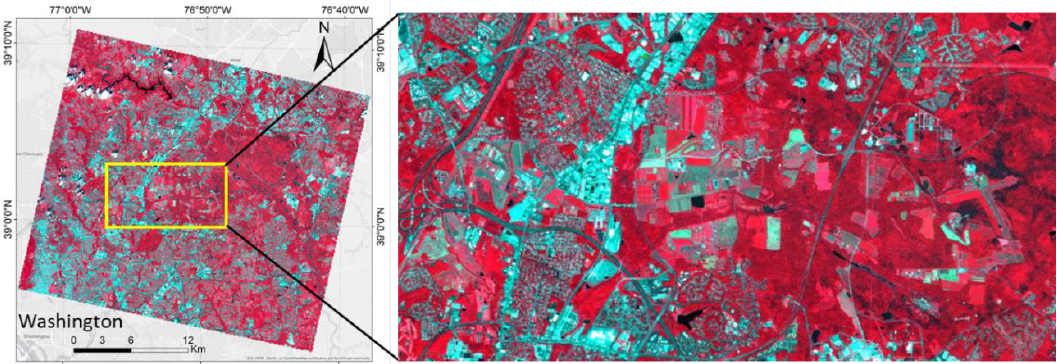
Figure 1. Beltsville Agricultural Research Center (BARC) study site (yellow rectangle and zoom-in figure, northeast suburbs of Washington D.C.). A VENµS false color composite image (Red: near-infrared band; Green: red band; Blue: green band) acquired on 13 July 2019, is overlaid on an Esri ArcGIS online base map.